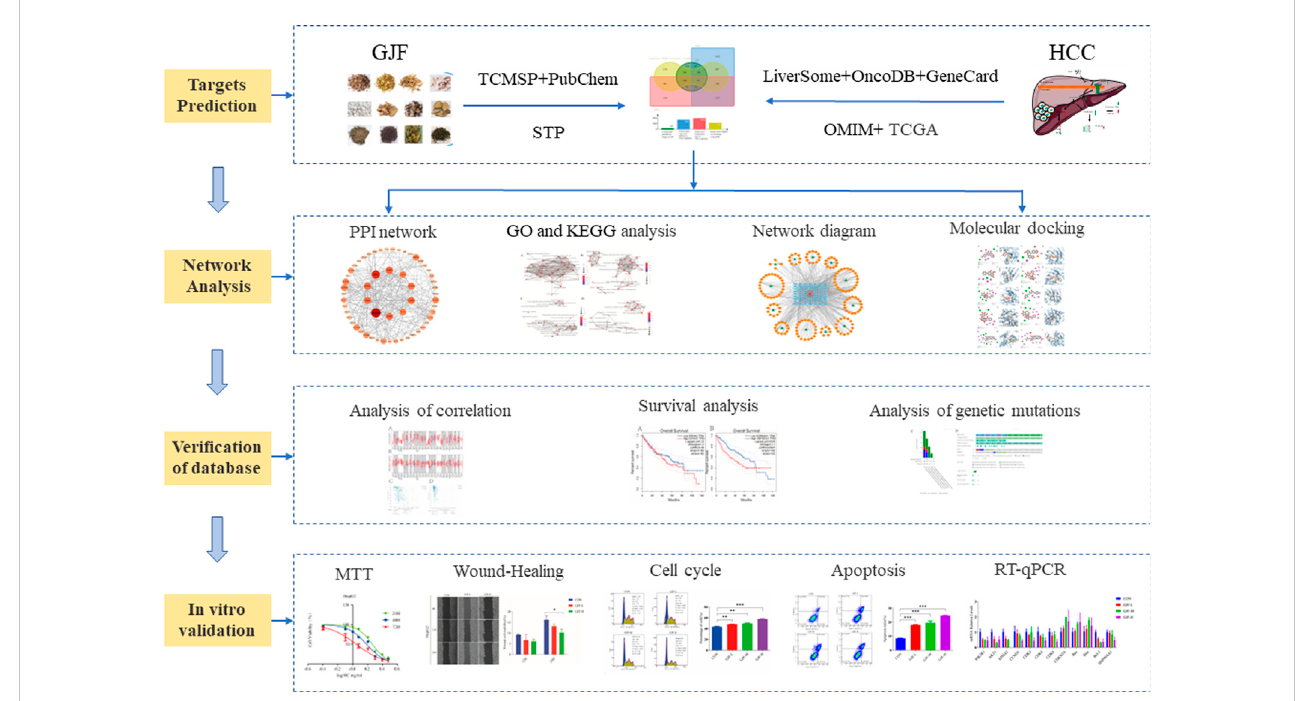
FIGURE 1 Overall work fl ow of this study (GJF, Ganji Fang; TCMSP, Traditional Chinese Medicine System Pharmacology database; STP, SwissTargetPrediction database; HCC, Hepatocellular